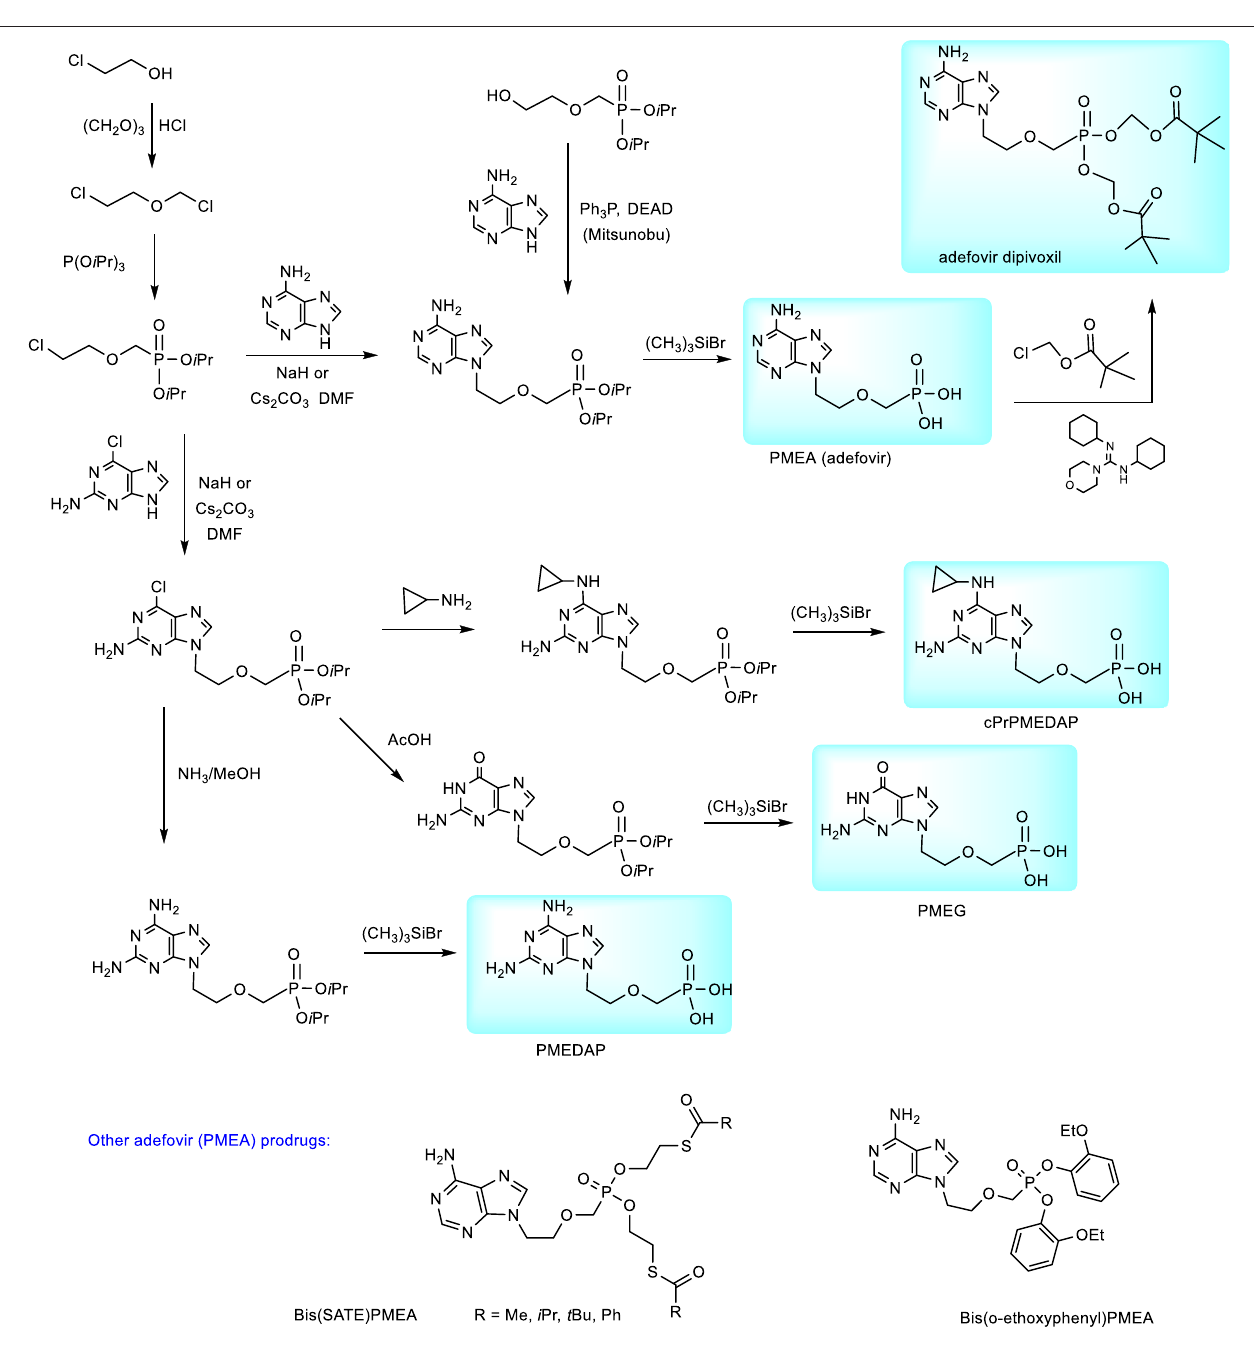
FIGURE 3 | Synthesis of purine N -2-(phosphonomethhoxy)ethyl (PME) derivatives.